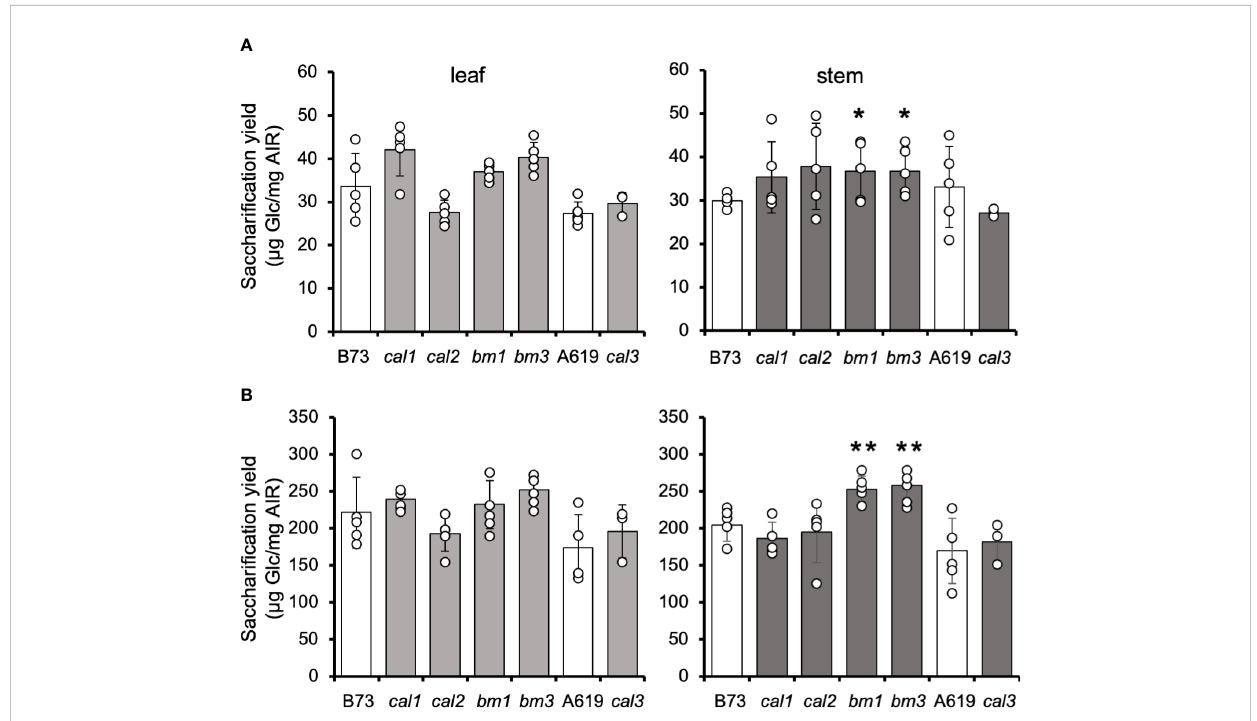
FIGURE 2 Sacchari fi cation yield of cal adult tissues. Amounts of glucose released from dAIR after 20-h enzymatic digestion from untreated (A) and NaOH- pretreated (B) mature leaves and stems. Values are means ± SD (n ≥ 3. Asterisks indicate signi fi cant differences from the wild type plants using the unpaired Student's t-test p -value < 0.05 (*); p -value < 0.01